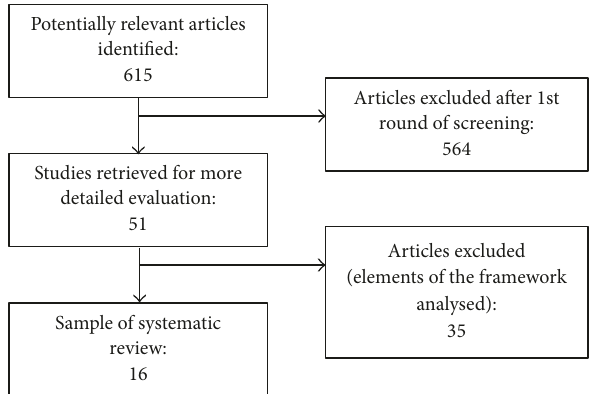
Figure 1: Systematic review flow